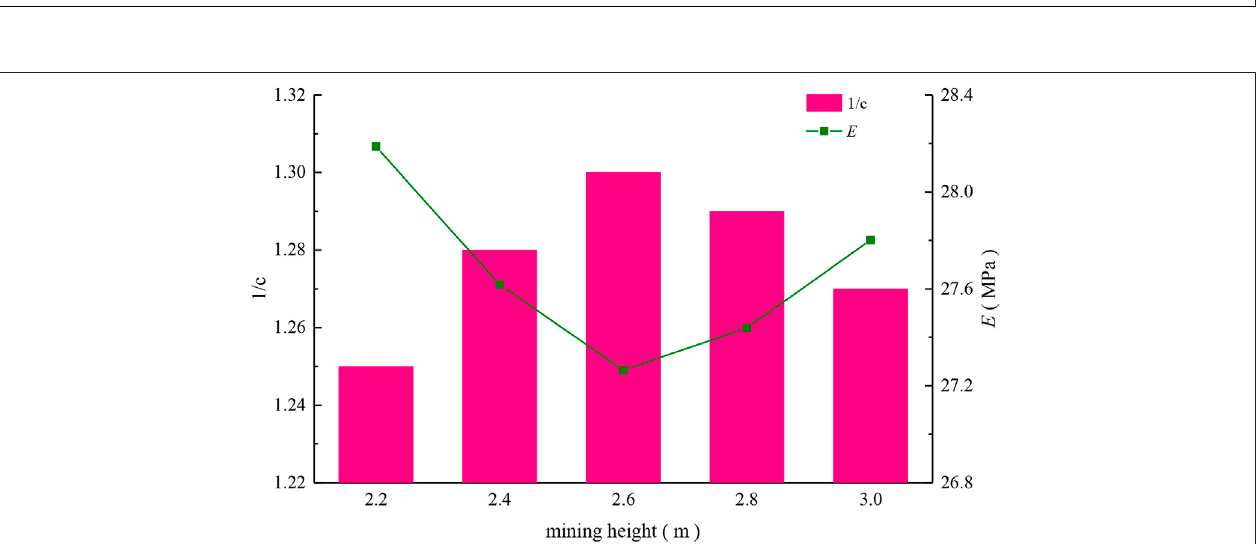
FIGURE 9 | Distribution of mass ratios of mining and back fi lling with the change of mining heights.